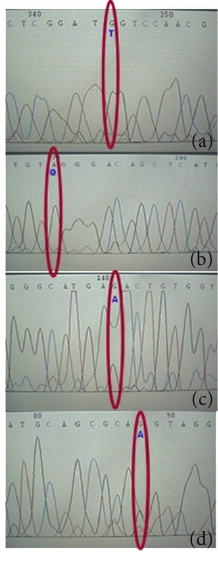
Figure 2: Schematic representation of the four Mexican patients . In this figure is presented point mutation by sequencing. (a) represents the mutation A8003C, (b) represents the mutation for T8082C, (c) represents C8201T, and (d) represents